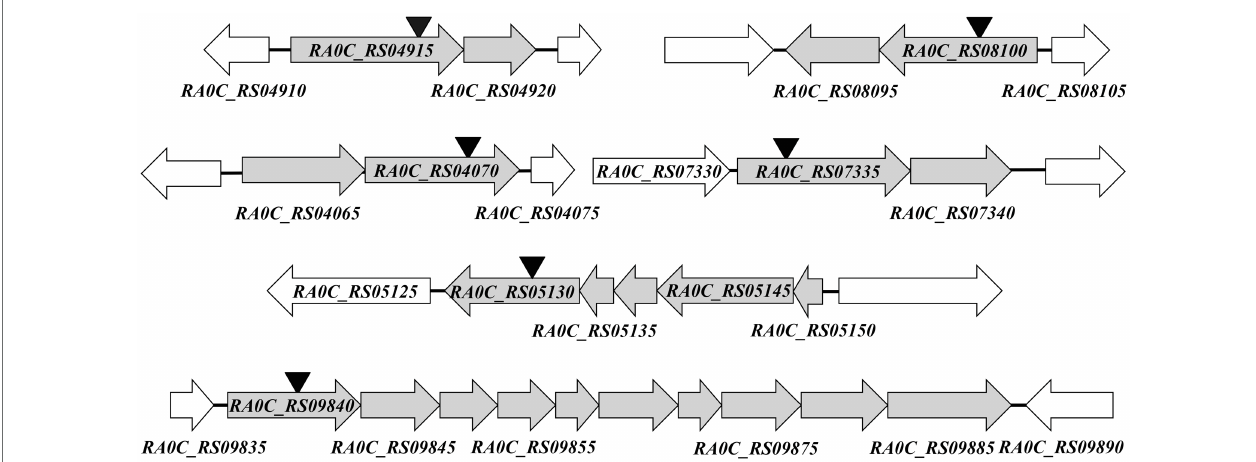
FIGURE 2 | Prediction of hypothetical operons of genes involved in natural transformation in RA ATCC11845. The prediction was performed by BioCyc pathway/ genome database collection (Footnote 1). Each horizontal arrow indicates the location of the coding region and the direction of transcription for each gene. The name of the genes is shown below or in the arrows. The sites of HimarEm1 insertion are indicated by inverted triangles.